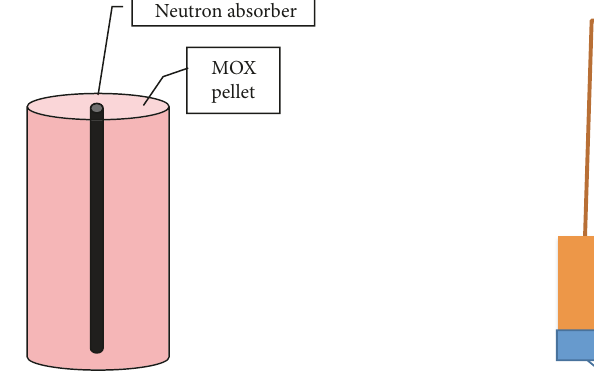
Figure 1: Concept of Duplex pellet with neutron absorber material. A hole with a diameter of approximately 1mm is provided at the center of the fuel pellet.